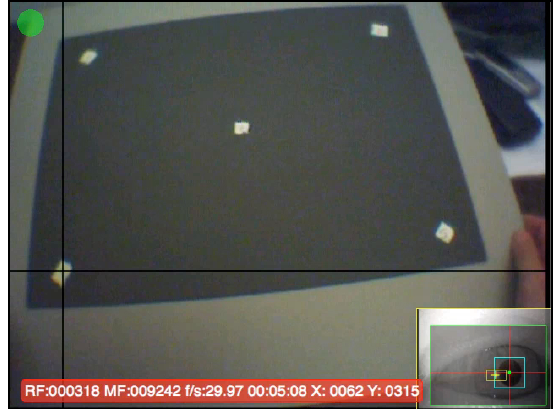
Figure 4. Static point array method for conducting a five- point calibration on mobile eye-trackers. In this video still from research conducted our laboratory, observers who were tracked while assembling a small device viewed five calibration stickers affixed to a hand-held